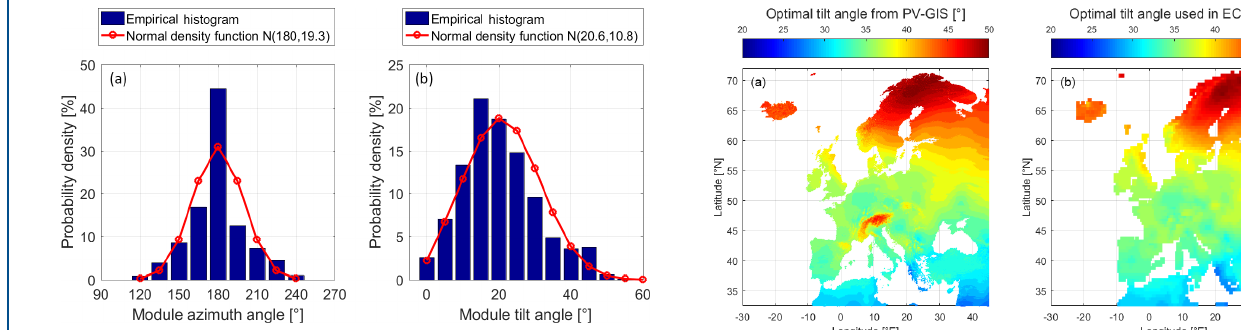
Figure 4. (a) Optimal tilt angles taken from the PV-GIS website (http://re.jrc.ec.europa.eu/pvgis/). (b) Optimal tilt angles used for the present work where high values present in mountainous regions have been filtered